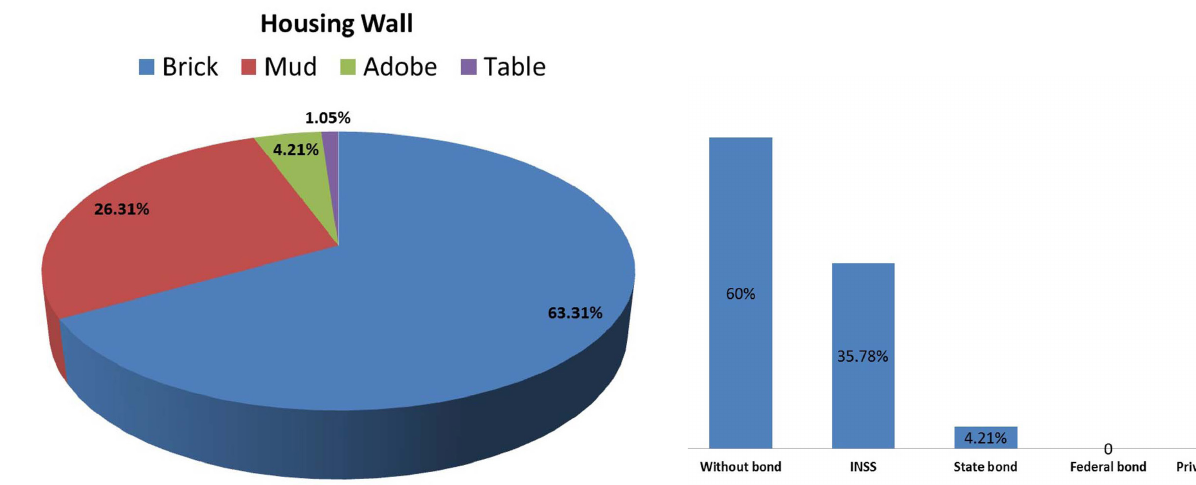
Fig. 1 - Housing wall of children with congenital cardiopathies in São Luís (2011 and 1 st semester 2012).